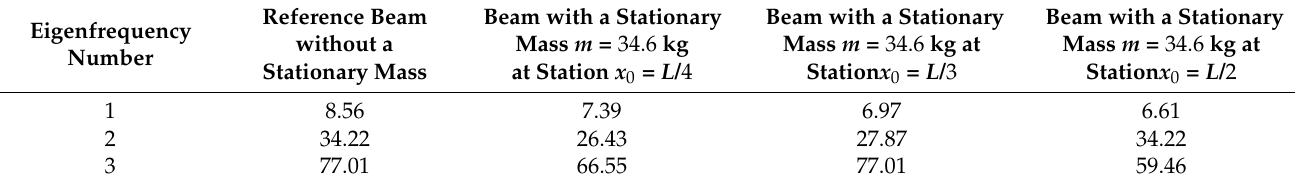
Table 2. Eigenfrequencies (Hz) of the model bridge comprising a primary system (beam) and a secondary system (fixed